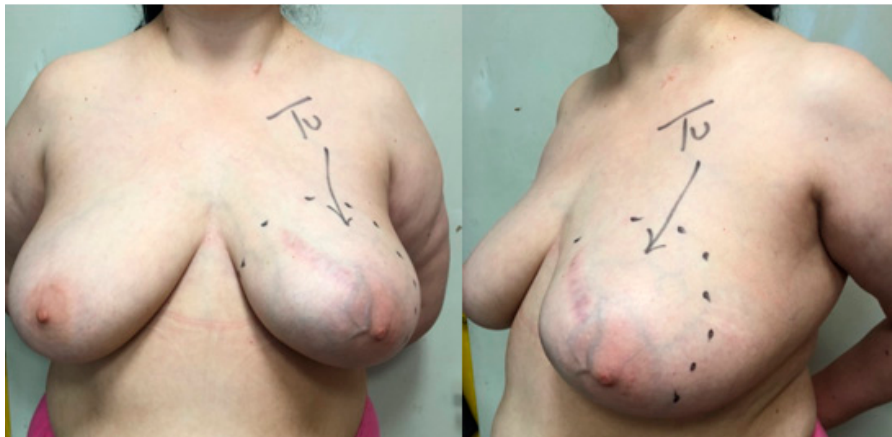
Figure 3. Preoperative images of bilateral hypertrophic breasts; the postoperative scar, enlargement and deformation of the left breast are to be noted.